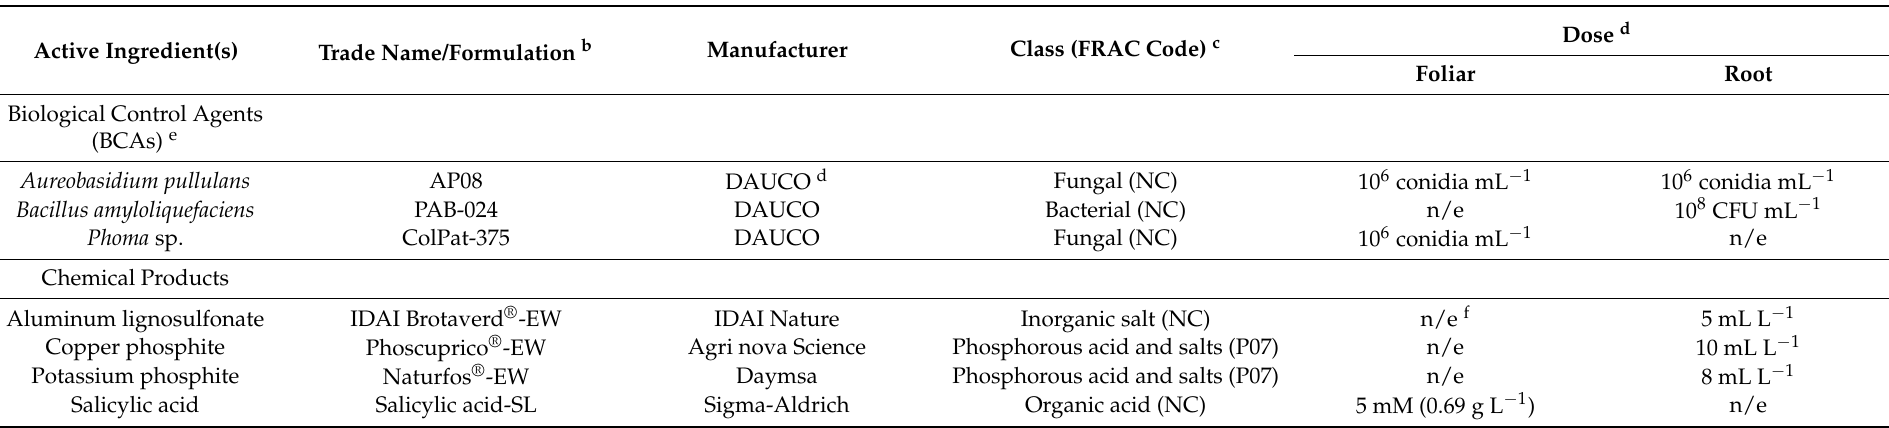
Table 4. Biological and chemical products evaluated in this study a